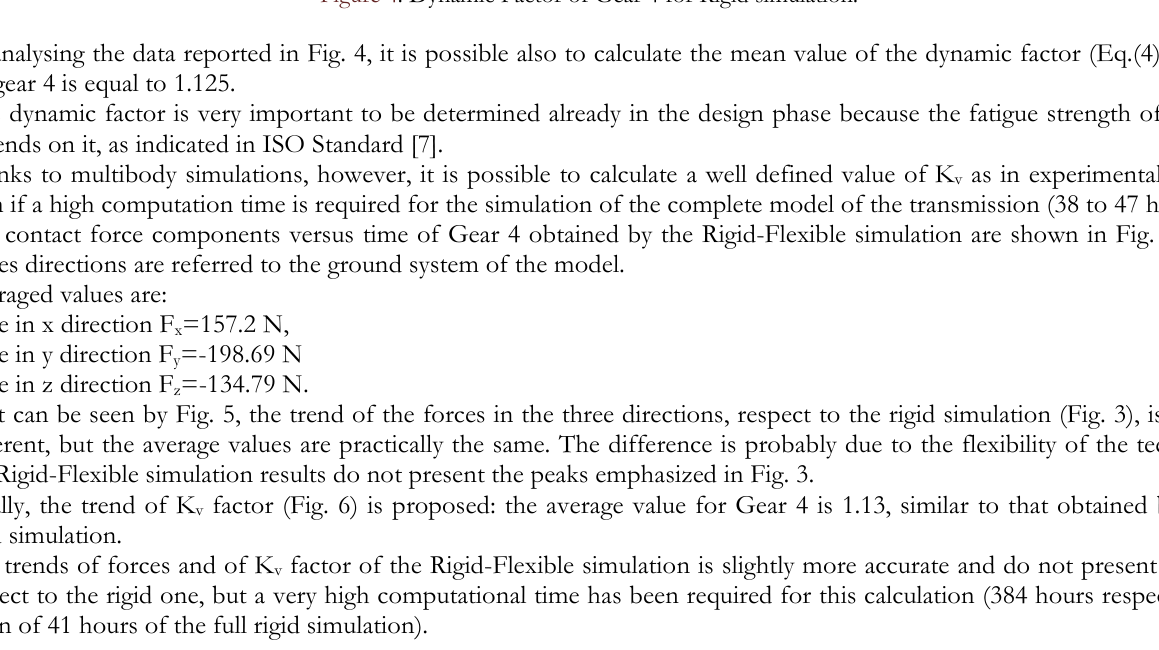
Figure 4: Dynamic Factor of Gear 4 for Rigid